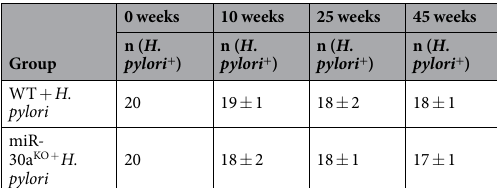
0 weeks 10 weeks 25 weeks 45 weeks n ( H. n ( H. n ( H. n ( H. pylori + ) Group pylori + ) pylori + ) pylori + ) WT + H. pylori 20 miR- 30a KO + H. pylori Table 1. Rapid urease test and Giemsa staining results for the gastric mucosa of the H. pylori -infected wild type (WT) mice and miR-30a KO mice. Note: All the animal experiments were independently repeated three times, and the interval time between each time of experiment was about one month. In each experiment, the initial numbers of mice in each group for each time was 20. H. pylori + represents H. pylori positive. After 10 weeks, 25 weeks and 45 weeks, several of the 20 WT/ H. pylori mice or the 20 miR-30a KO / H. pylori mice died of natural causes. The rapid urease test results were consistent with the Giemsa staining